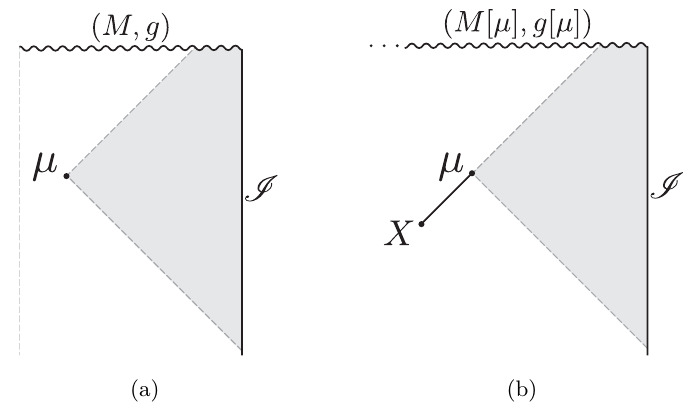
Figure 2 . (a) An apparent horizon µ (more precisely, a minimar surface) in a spacetime ( M, g ) . (b) The same apparent horizon in its corresponding coarse-grained spacetime ( M [ µ ] , g [ µ ]) , where there HRT surface X with respect to I is null related to µ . The shaded wedge outside µ is common to both